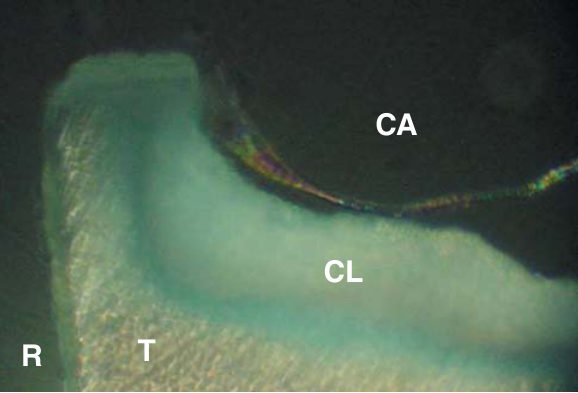
FIGURE 2- Polarized light microscopy showing caries lesion (CL) with cavitation (CA) without association with the restoration (R). Tooth